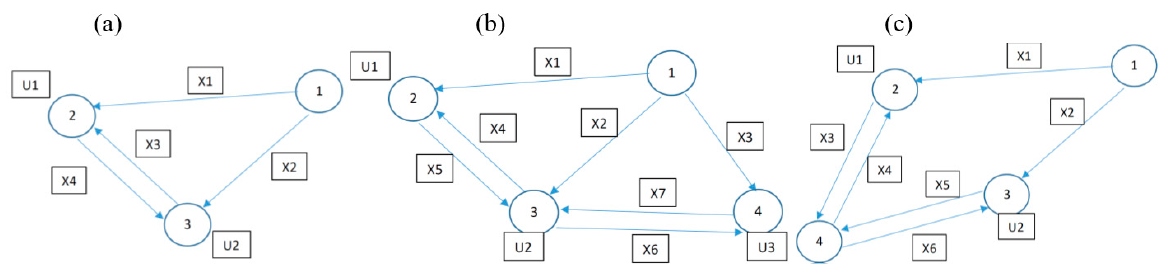
Figure 2. Simple networks with loops. The variables are marked in the rectangles. The node numbers are in circles. ( a ) three-node case; ( b ) four-node case 1; ( c ) four-node case 2.